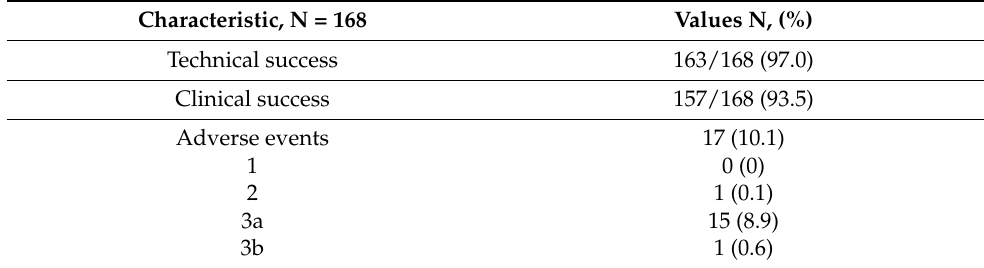
Table 3. Outcomes overall. Graded according to the AGREE classification